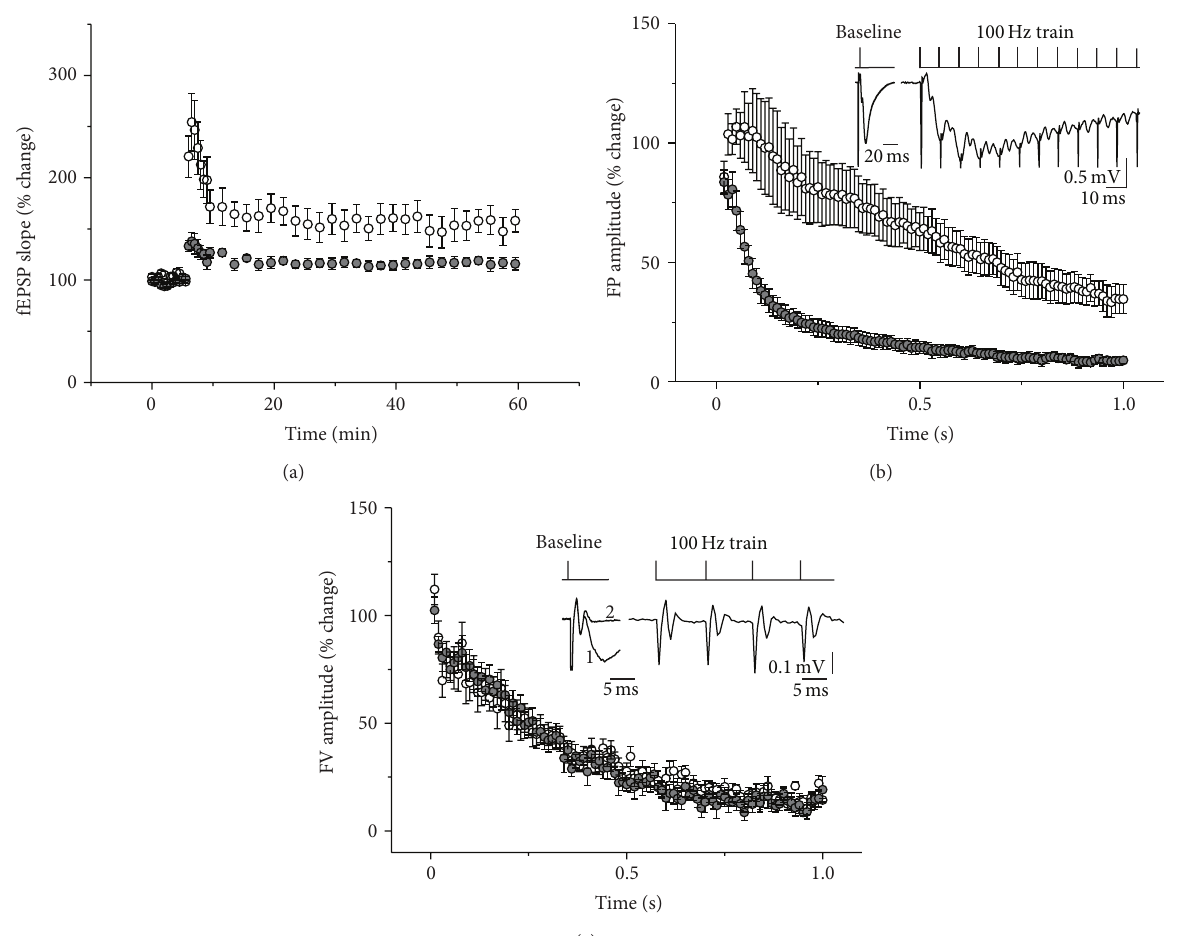
Figure 4: Effect of inhibition of NEU activity on the long-term potentiation and the short-term depression in hippocampal CA3-to-CA1 networkinducedby100 Hzstimulustrain.(a)Averageofbaseline-normalizedinitialslopesoffEPSPevokedbystimulationofShaffercollateral before and after delivery of 100 Hz train in control (white) and NADNA-pretreated slices (grey). (b) Summarized changes in field potentials recorded during 100 Hz stimulation in control (white) and NADNA-pretreated slices (grey). Each point in the graph represents averaged amplitude of the field potential recorded at the time point of 9.5 ms after every stimulus delivery during train and normalized to baseline fEPSP amplitude. Inset: examples of baseline field potentials and fragment of field potential recording during 100 Hz stimulation from the same slice. (c) Summarized changes of fiber volley (FV) amplitude during 100Hz stimulation in control (white) and NADNA-pretreated slices (grey) recorded in the presence of NMDA and non-NMDA receptor antagonists (resp., D-APV and CNQX). Each point in the graph represents averaged FV amplitude recorded after every stimulus delivery during the train and normalized to baseline FV amplitude. Inset: examples of baseline field potentials recorded from NADNA-pretreated slice before (1) and after (2) application of glutamate receptor blockers and fragment of field potential recording during 100 Hz stimulation from the same slice. All data are presented as Mean ±